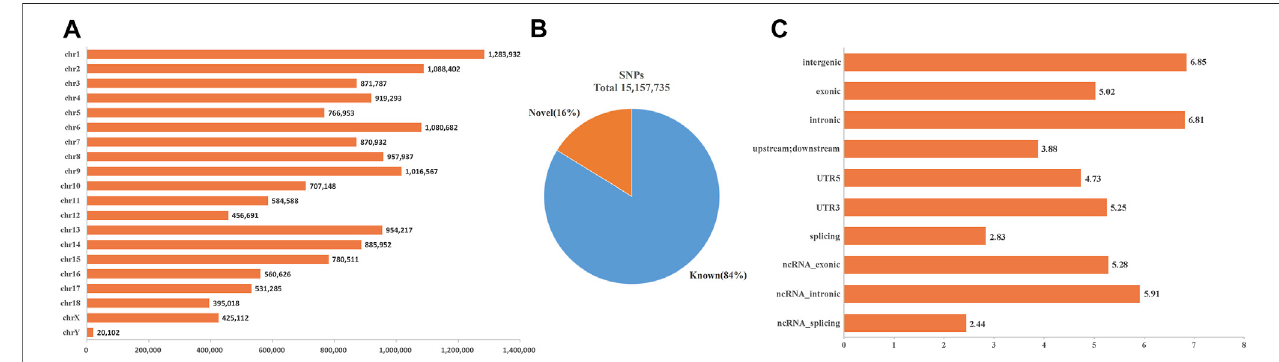
FIGURE1| SNVcharacteristicsofBeijingBlackpopulation. (A) Genome-widedistributionofdetectedSNVson19chromosomesfortheBeijingBlackpigs. X -axis represents the number of SNVs. Y -axis represents 18 autosomes and X chromosome. (B) The percentage of Beijing Black SNVs within the dbSNP database. (C) Genome-wide annotation of Beijing Black genetic variations. X -axis represents the number of genetic variations (log10) within various functional regions. Y -axis represents various functional regions.